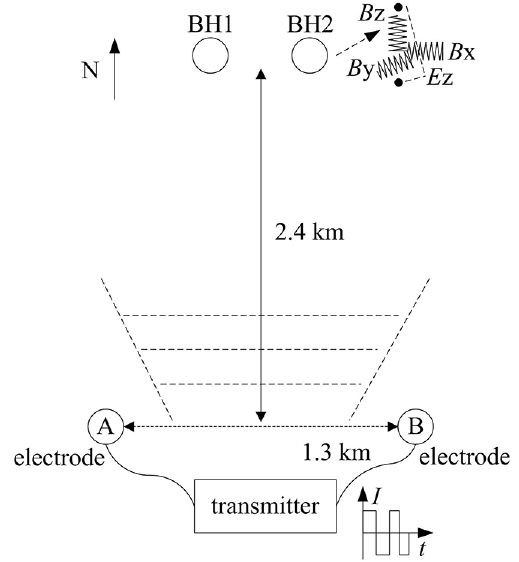
Figure 9. Field layout of the experiment. BH1 and BH2 are placed at a certain depth in the borehole. The transmitter and the electrodes are on the